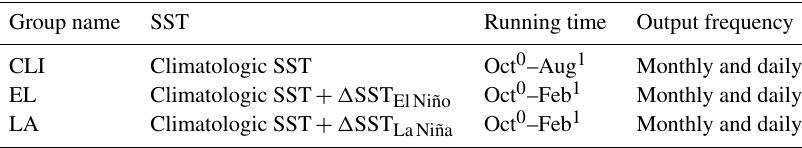
Table 1. Simulation setup.